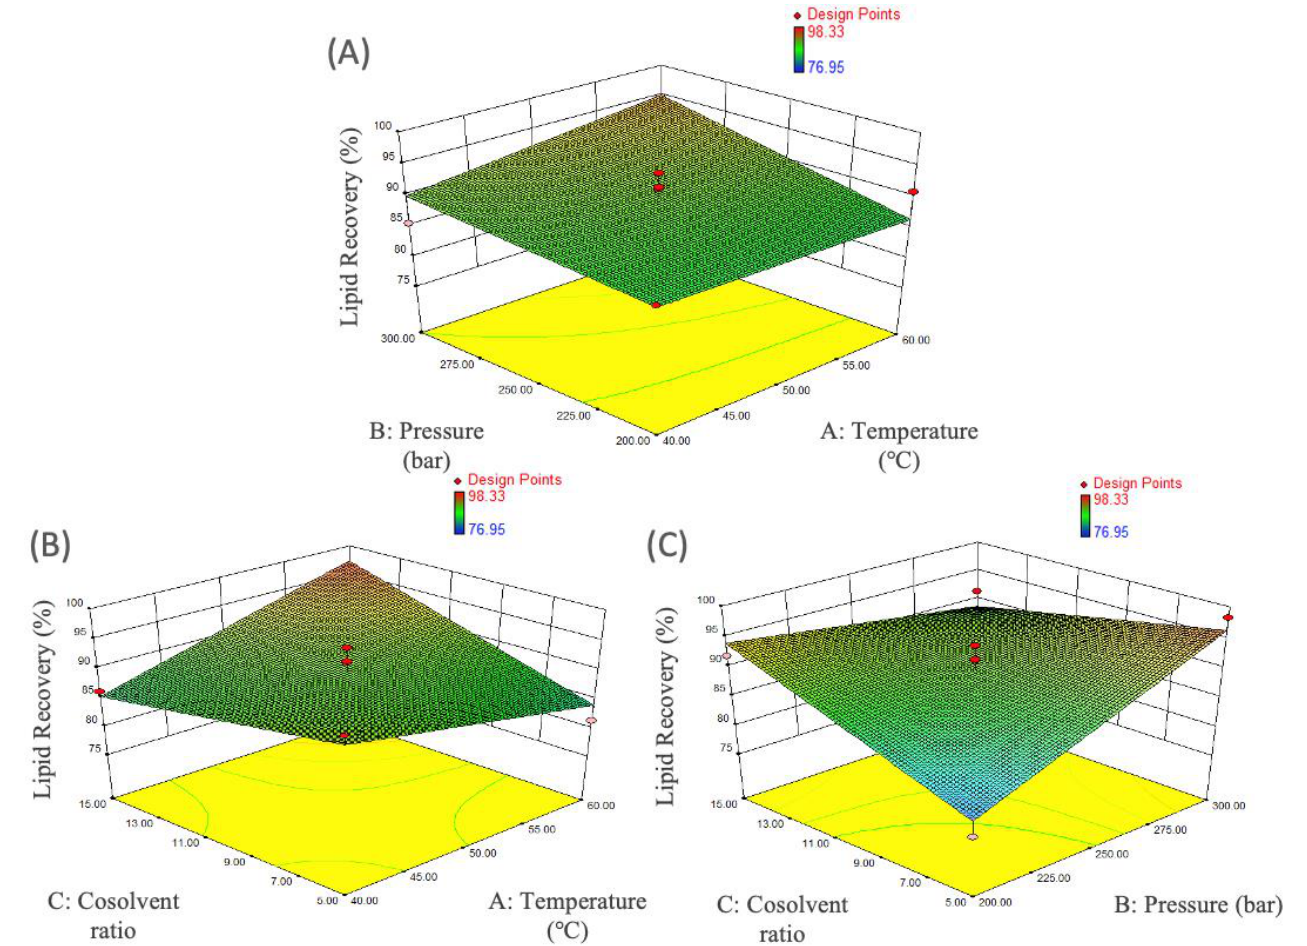
Figure 3. Response surface plot fixed on ( A ) cosolvent ratio 1:10, ( B ) pressure 250 bar and ( C ) tem- perature 50 °C to show the effect of pressure, temperature and cosolvent ratio on lipid recovery of M. alpina FU30797 from SC-CO 2